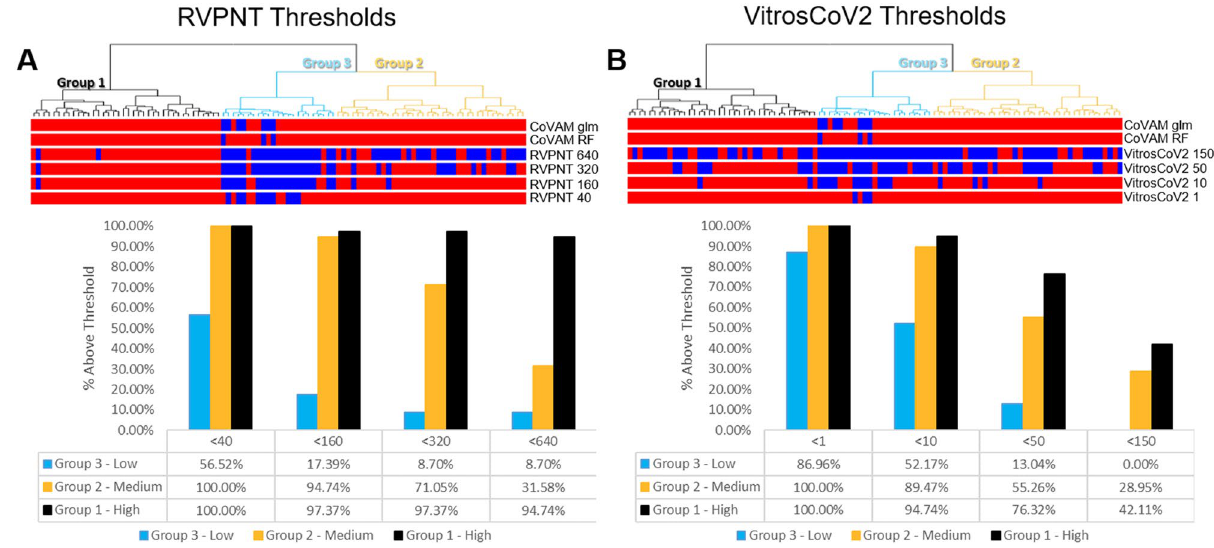
Figure 7. SARS-CoV-2 Reactivity Classification. In both ( A ) (comparison to RVPNT NT50 thresholds) and ( B ) (comparison to VITROS CoV2T S/C thresholds), the bars across the top represent the classification for each given sample. The color red represents samples classified as reactive and the color blue, samples classified as non-reactive. The top 2 bars represent the COVAM reactivity predictions with the top bars the prediction based on the random forest model and the second bars the prediction from the logistic regression model. The bar graphs represent the % of samples classified as reactive on each cutoff value. This figure was generated using the R programing language, version 4.0.2 (https:// www.r- proje ct. org/) and MICROSOFT Excel version 2016, www. micro soft.